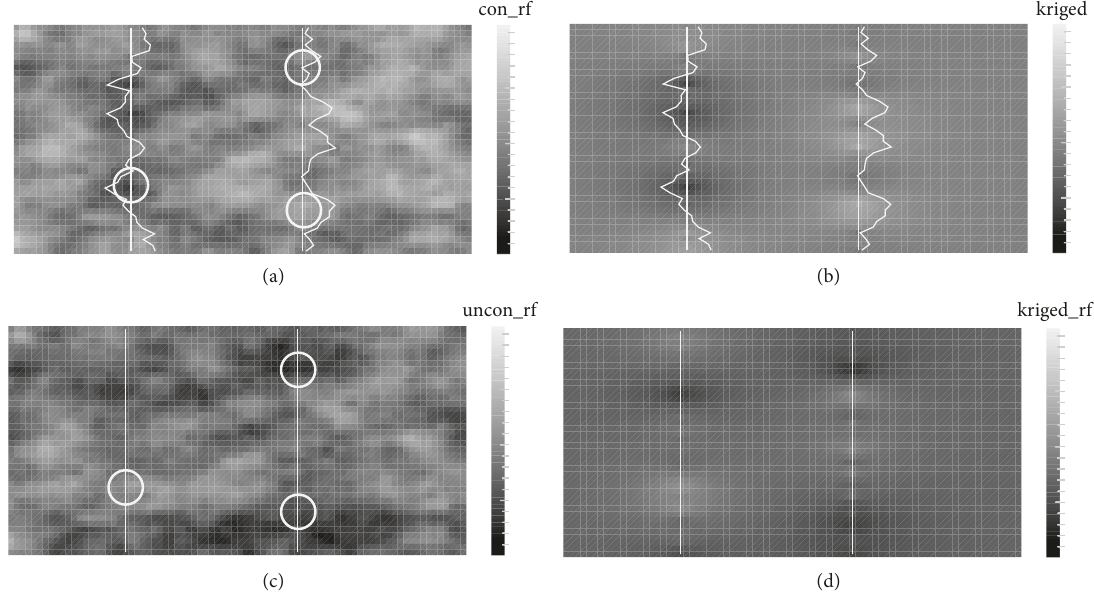
Figure 5: The four fields for realisation j . (a) Conditional random field j . (b) Kriged field based on measurements. (c) Unconditional random field j . (d) Kriged field j based on random values at measurement locations.